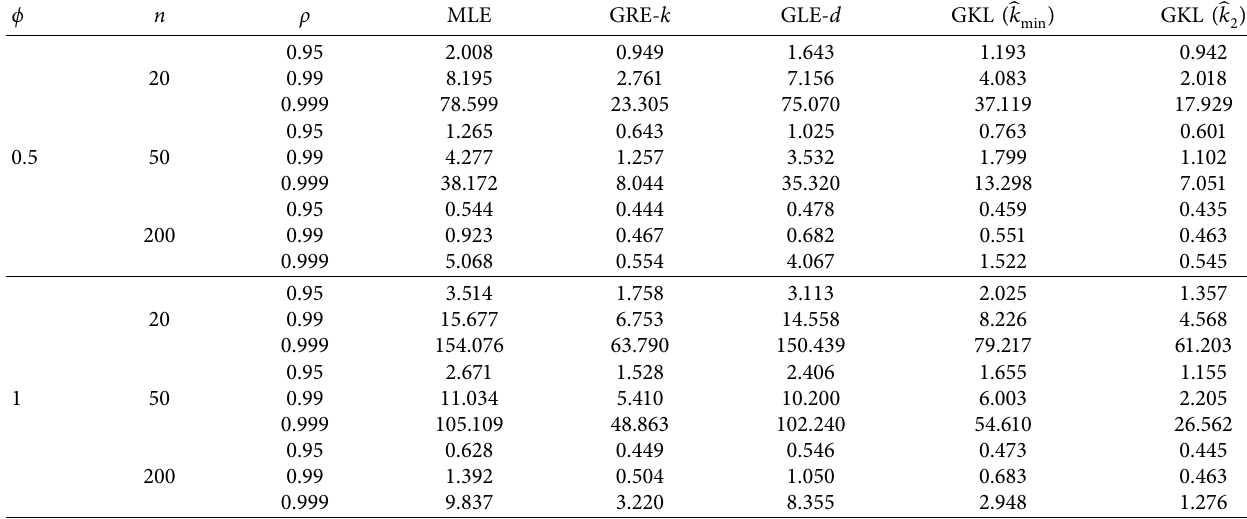
Table 1: Estimated mean squared error when p =4.